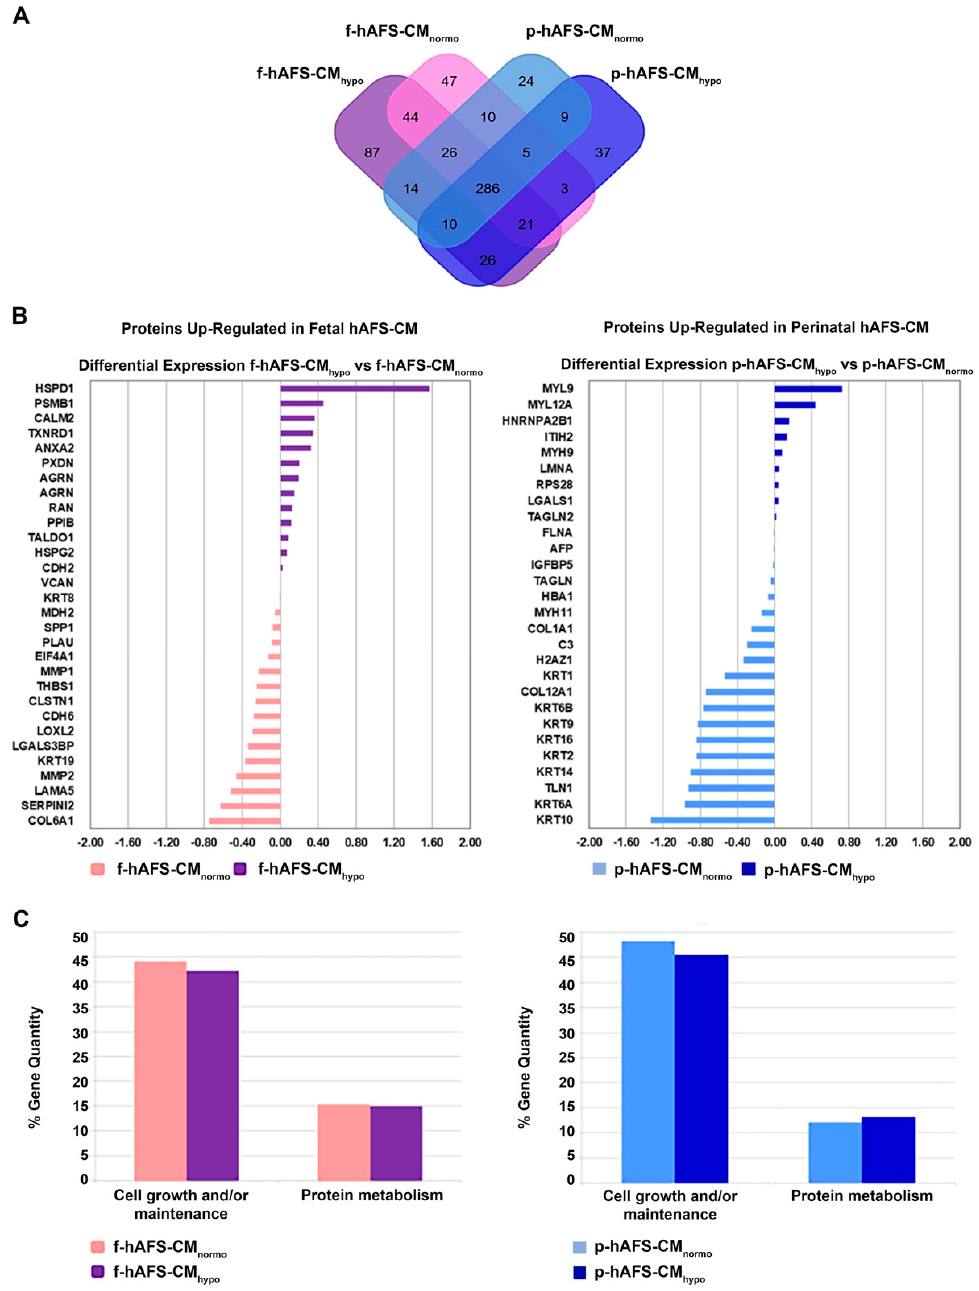
Figure 5. Comparative proteomics analysis of fetal- and perinatal hAFS-CM. ( A ) Venn diagram illustrating the distribution of proteins found with a frequency of at least 2 within f-hAFS-CM normo (pink), f-hAFS-CM hypo (purple), p-hAFS-CM normo (light blue) and p-hAFS-CM hypo (blue). ( B ) Differentially expressed proteins identified in fetal hAFS-CM (left panel) and perinatal hAFS-CM (right panel) by label-free quantification with MAProMa software. Left panel: histogram plot refers to the differential expression between normoxic control (pink bars and negative DAveDAve values) and hypoxic (purple bars and positive DAve values) condition of proteins found up-regulated in f-hAFS-CM over p-hAFS-CM. Right panel: histogram plot reporting the differential expression between normoxic control (light blue bars and negative DAve values) and hypoxic (blue bars and positive DAve values) condition of proteins found upregulated in p-hAFS-CM over f-hAFS-CM. Proteins with DAve (ratio of protein expression) ≥ | 0.4 | and a DCI (confidence of differential expression) ≥ | 5 | passed the filters and were considered differentially expressed. For each protein, gene name and related DAve value are reported; see Table S2 for the complete list and detailed